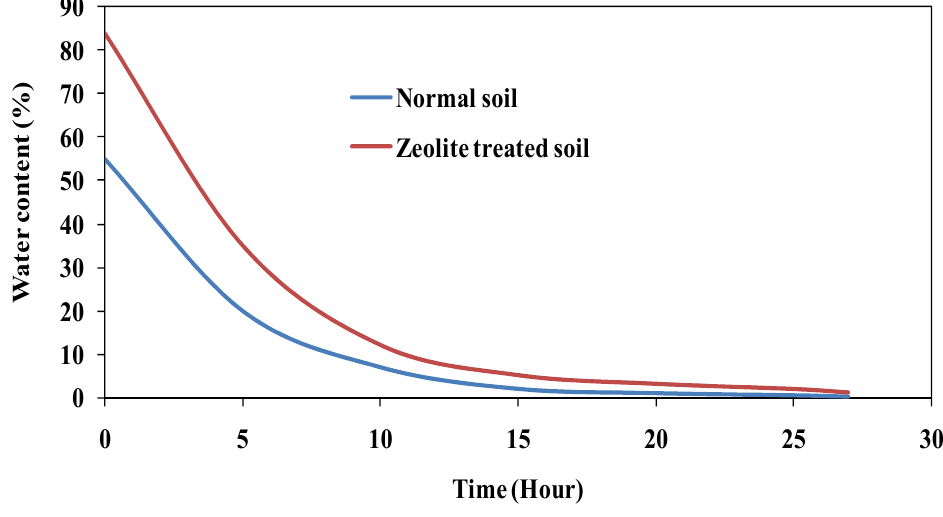
Figure 5. Soil Water Content as Influenced by Zeolitic Soil. Modified from Xiubin and Zhanbin [3].